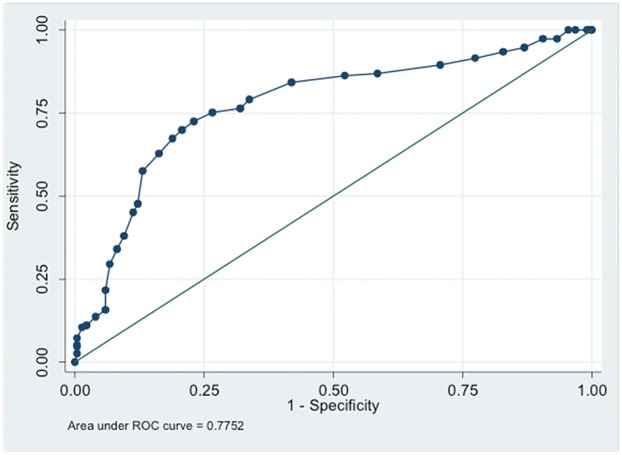
ROC curve analysis: Plot of sensitivity versus 1-specificity (PD-Q scale).